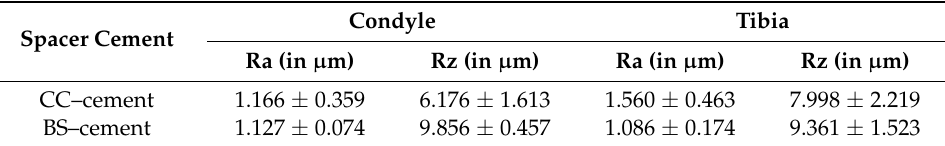
Table 2. Surface roughness values of the two investigated spacer cements.